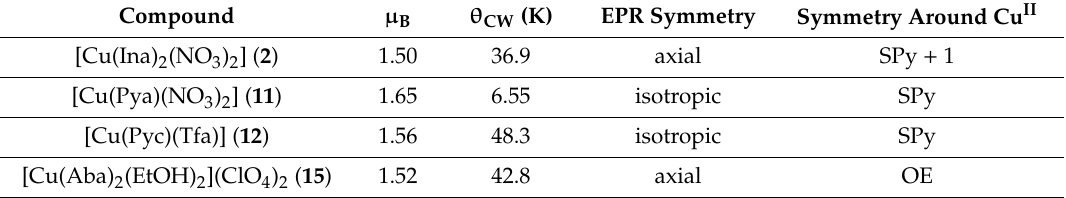
Table 4. Magnetic moments and Curie-Weiss constants of selected Cu II compounds. a Compound